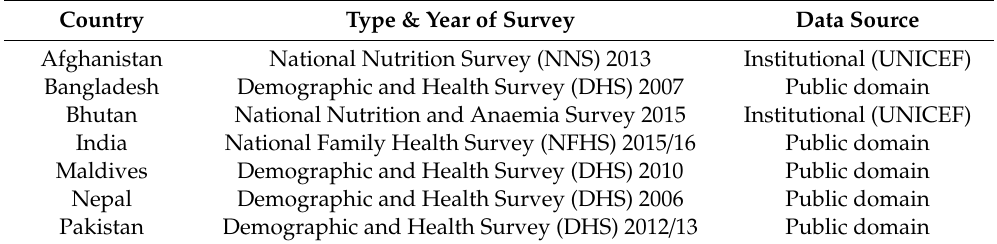
Table 1. Country-wise type of survey, year of survey and data source for selected country-specific survey data used in the current